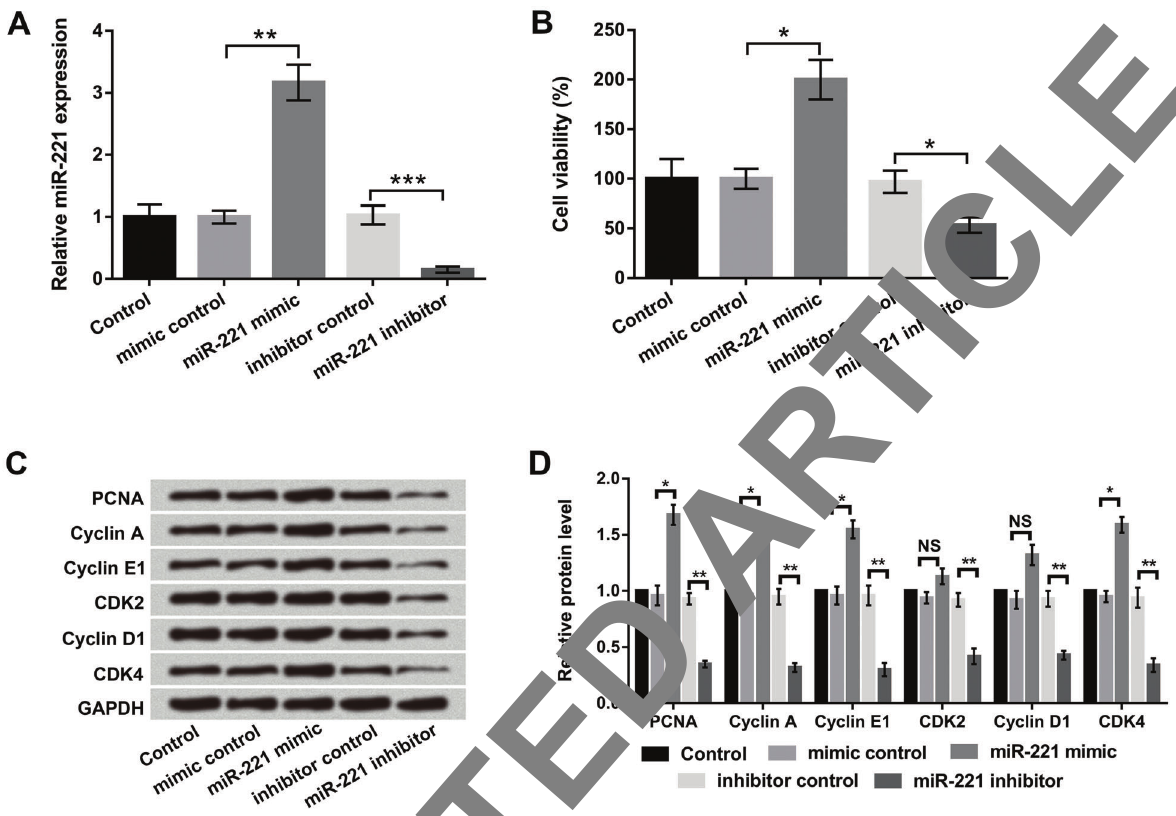
Figure 2. Overexpression of miR-221 promoted osteoblast proliferation. A , Expression of miR-221 in transfection of MC3T3-E1 cells was detected using qRT-PCR. B , Cell viability was measured using the CCK-8 assay. C and D , Western blot was used to measure the expression of cell cycle-related proteins. miR-221: microRNA-221; qRT-PCR: quantitative reverse transcription polymerase chain reaction; CCK-8: cell counting kit-8; PCNA: proliferating cell nuclear antigen; CDK: cyclin-dependent kinase; qRT-PCR: quantitative reverse tran- scription polymerase chain reaction. Data are reported as means ± SD. *P o 0.05, **P o 0.01, ***P o 0.001 (ANOVA). NS: not signi fi